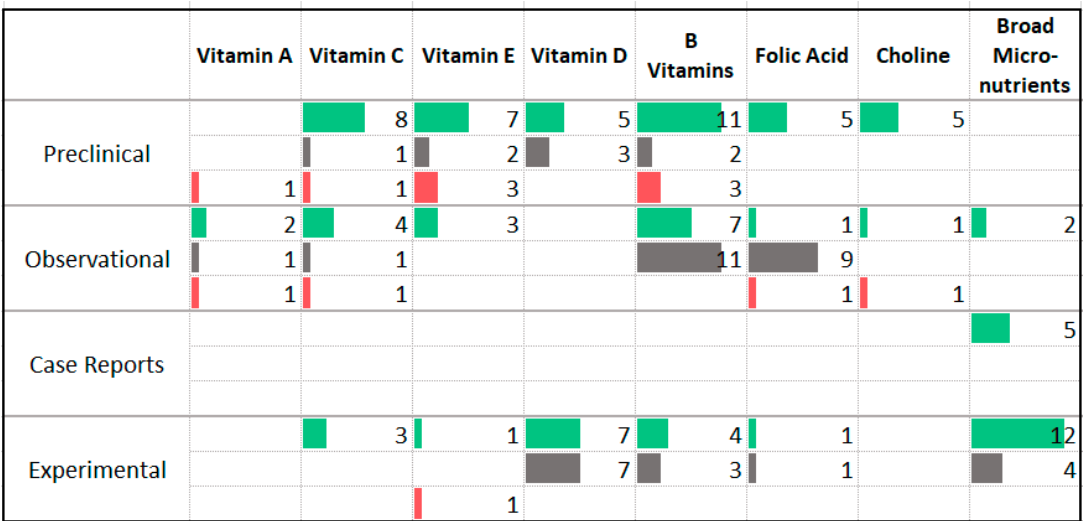
Figure 10. Studies assessing vitamins and anxiety. █ Higher intake or levels associated with decreased anxiety. █ No association between intake or levels and anxiety. █ Higher intake or levels associated with increased anxiety.